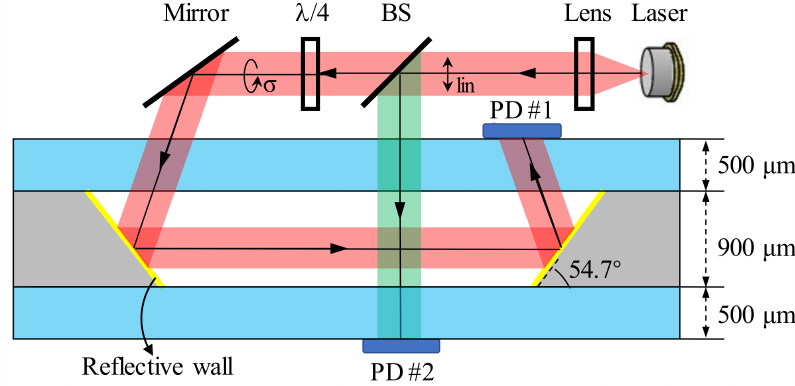
Figure 2. Integration architecture schematic for chip scale atomic sensors with redirected laser beams in microfabricated vapor cells. The red light represents the pump beam and the green light is the probe beam. BS: Beam